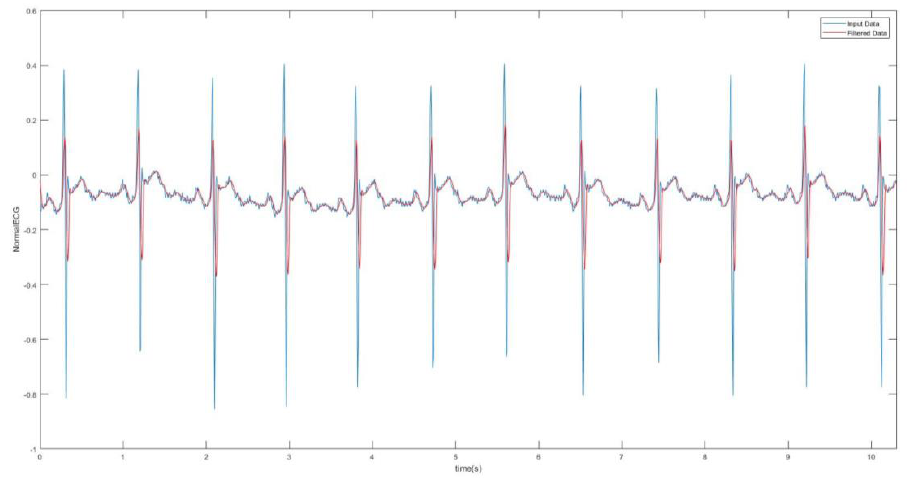
Figure 5. Healthy filtered ECG.